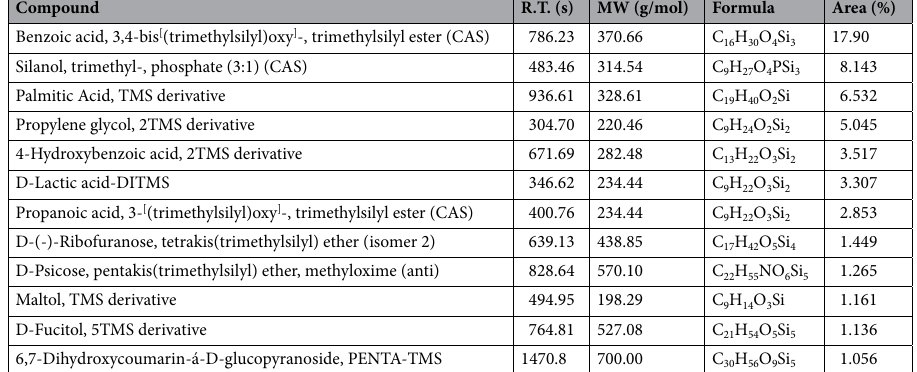
Table 1. The list of major compounds (> 1%) identified in bioconverted product by GCxGC/TOF–MS